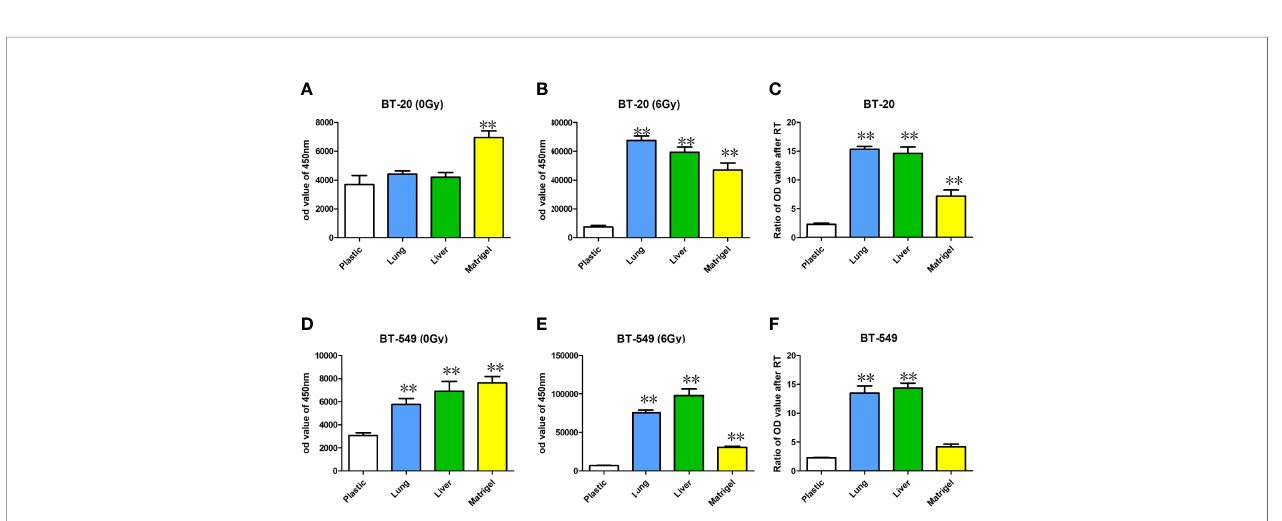
FIGURE 5 | ROS were measured with DCF-DA staining with BT-20 and BT-549 breast cancer cell lines before (A, D) and after radiotherapy delivery (B, E) . The relative increases in ROS can be found in (C, F) . Data represent mean ± S.E.M. * denotes P<0.05, ** denotes P<0.001.